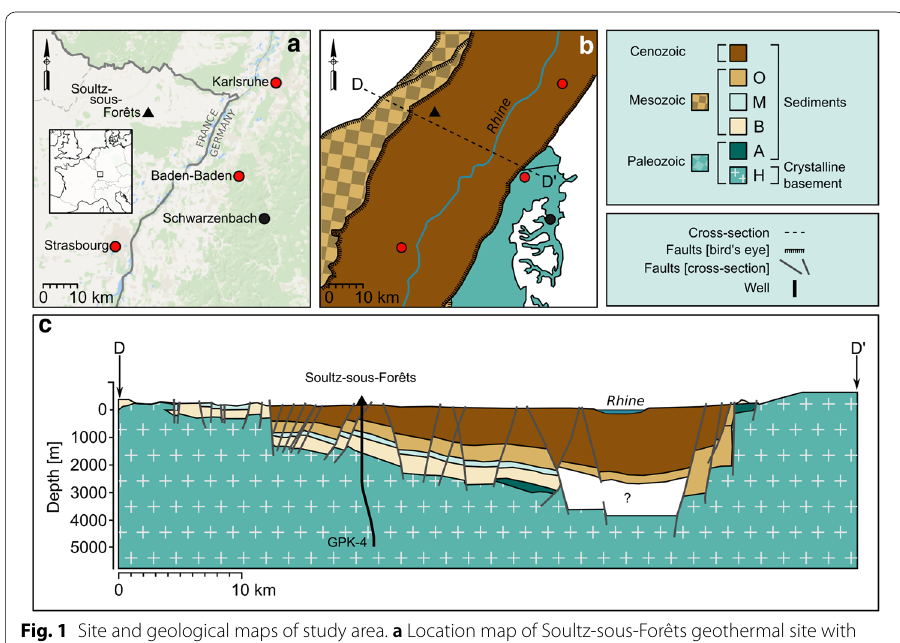
Fig. 1 Site and geological maps of study area. a Location map of Soultz-sous-Forêts geothermal site with respect to nearby cities (red circles) and Schwarzenbach sampling site (black circle). b Simplified geological map of the area shown in a , indicating location of cross-section shown in c . Modified after Dezayes et al. (1995) and Stober and Bucher (2015). c Geological cross-section of the Upper Rhine Graben region, modified after Stober and Bucher (2015) and Aichholzer et al. (2016). The open-hole section of the GPK-4 well is situated in the Hercynian (Variscan) crystalline basement. Geological unit abbreviations: H Hercynian = basement; A anté-Annweiler; B Buntsandstein; M Muschelkalk; O other mesozoic = = = =